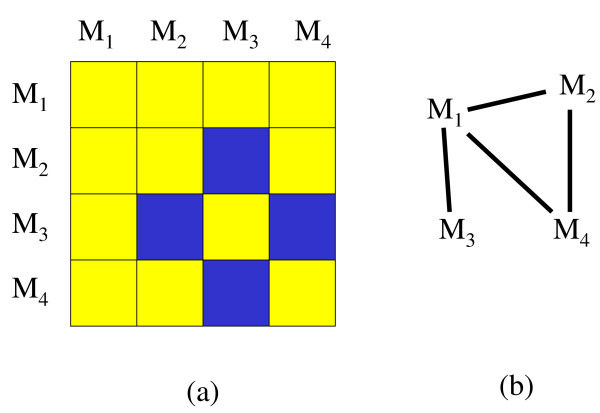
Simple example of a cluster sub-matrix. The cluster is represented by its matrix (a) and its corresponding sub-graph (b). "1" entries are designated as yellow boxes, "0" entries as blue boxes. Note, that the main diagonal entries are set to "1".